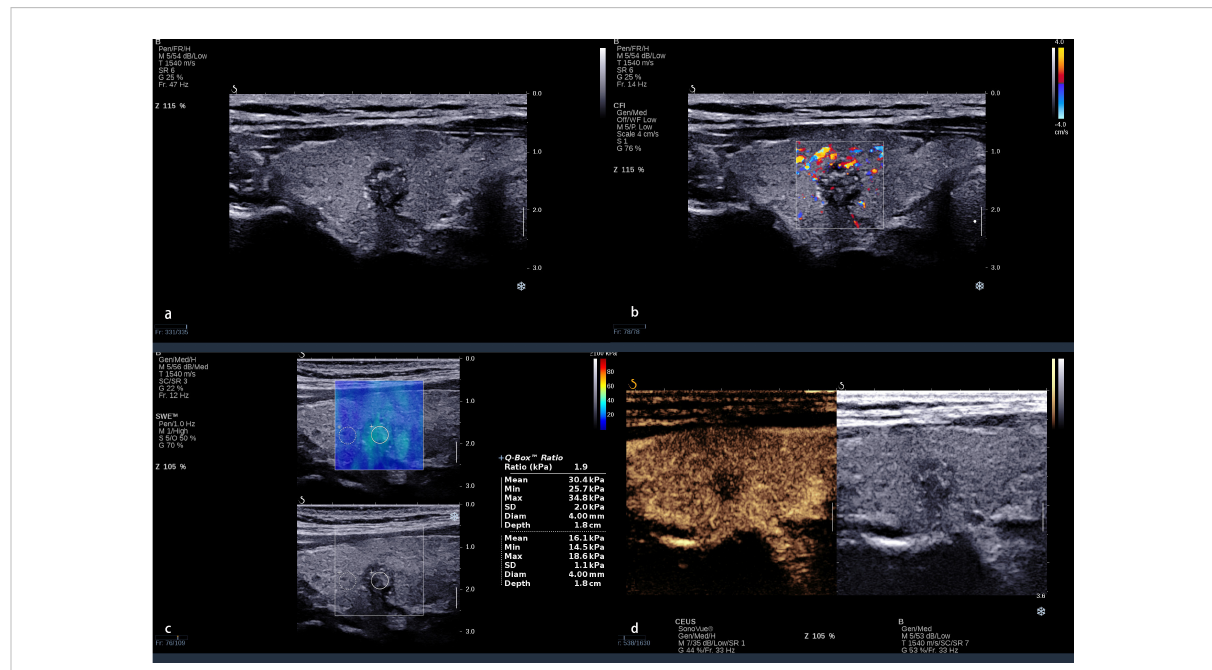
FIGURE 4 A 38 year-old-woman with a nodule in the right lobe of the thyroid. (A) Conventional ultrasound revealed an 8 × 9-mm solid hypo-echoic nodule with an irregular margin, shape that was taller-than-wide, and with punctate echogenic foci; this was categorized ACR TI-RADS 5. (B) The nodule presented a spot blood fl ow signal. (C) Quantitative shear wave elastography (SWE) revealed 25.7 kPa for Emin, 30.4 kPa for Emean, 34.8 kPa for Emax, and 1.9 for Eratio. (D) Qualitative contrast-enhanced ultrasound (CEUS) of the nodule revealed heterogenous, hypo- enhancement. Even the Emax was <46.8 kPa; the CEUS presented malignant enhancement patterns. The combination of CEUS and SWE recognized this nodule as malignant. The surgical pathology was papillary thyroid carcinoma with Hashimoto ’ s